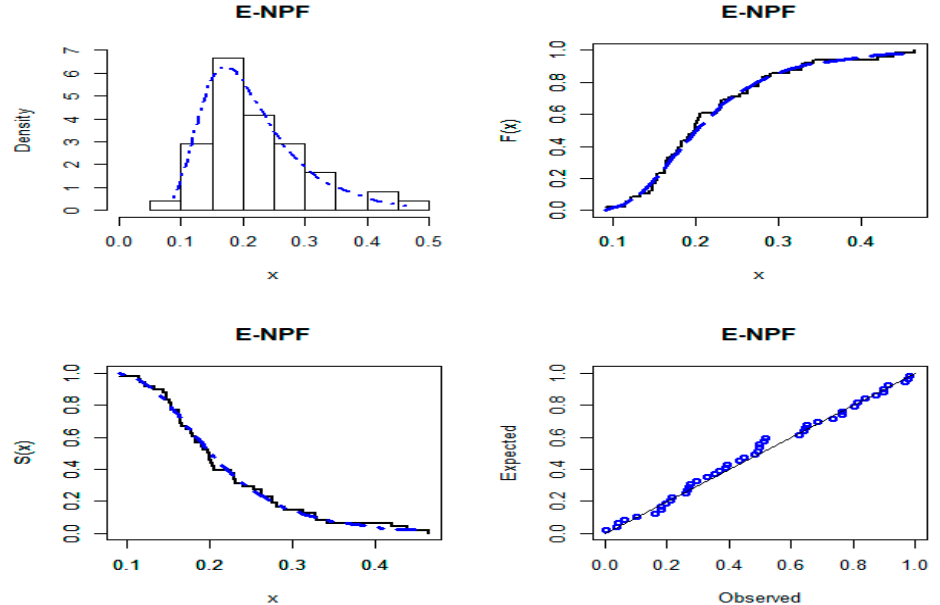
Figure 8. Curves of the E-NPF distribution for petroleum reservoir data.